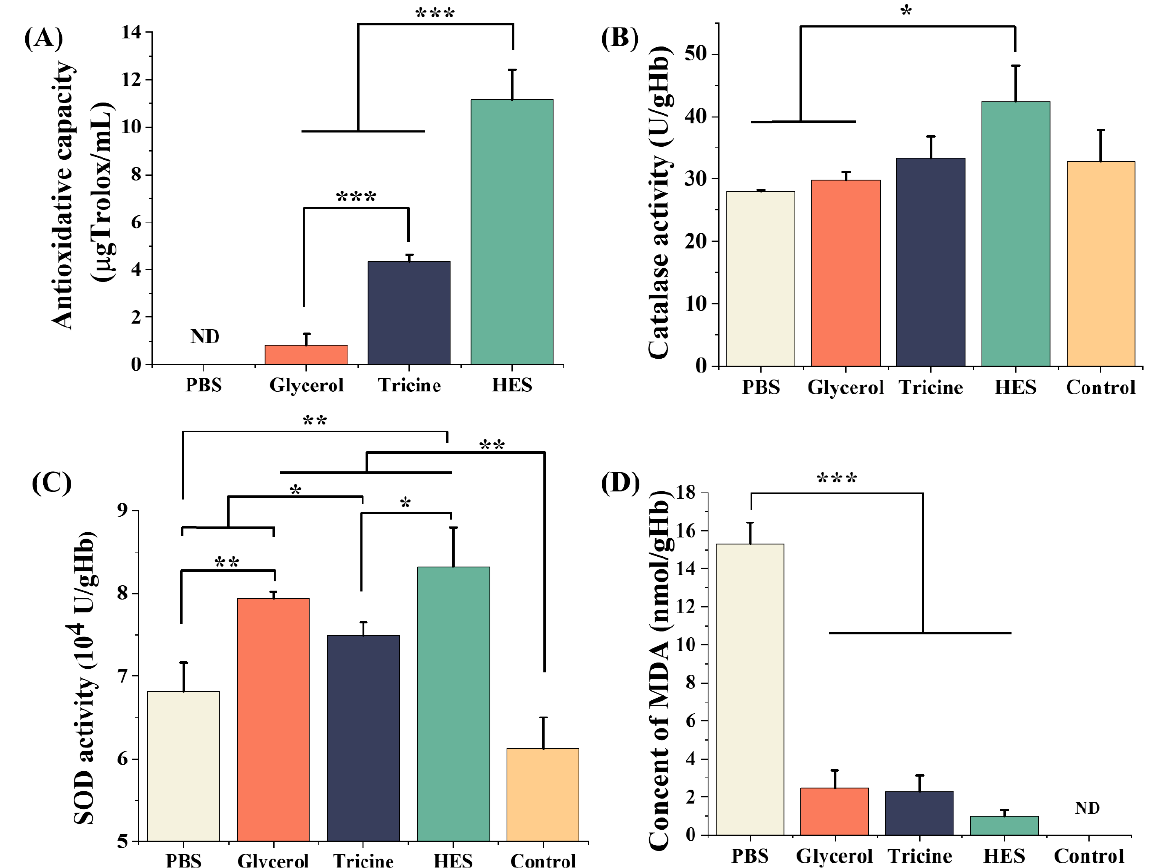
Figure 5. The ability to reduce oxidative damage. ( A ) The antioxidative capacity evaluated by DPPH assay. The catalase ( B ) and SOD ( C ) activities of RBCs cryopreserved in different solutions. ( D ) The lipid peroxidation of RBCs, the results are presented as the content of MDA. The control group comprised fresh RBCs without cryopreservation. The concentrations of glycerol, tricine and HES were 20%, 6% and 13%, respectively. Three replicates of each sample were tested and the data are shown as mean ±SD. * indicates p < 0.05, ** indicates p < 0.01, *** indicates p < 0.001.